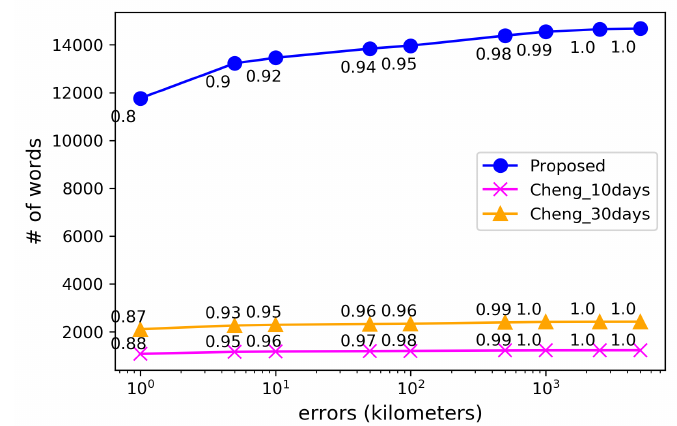
Figure 14. Location errors of the local words extracted by the proposed method and Cheng’s method, which are also in GeoNames. The numbers of the lines represent the ratio of the words with the corresponding